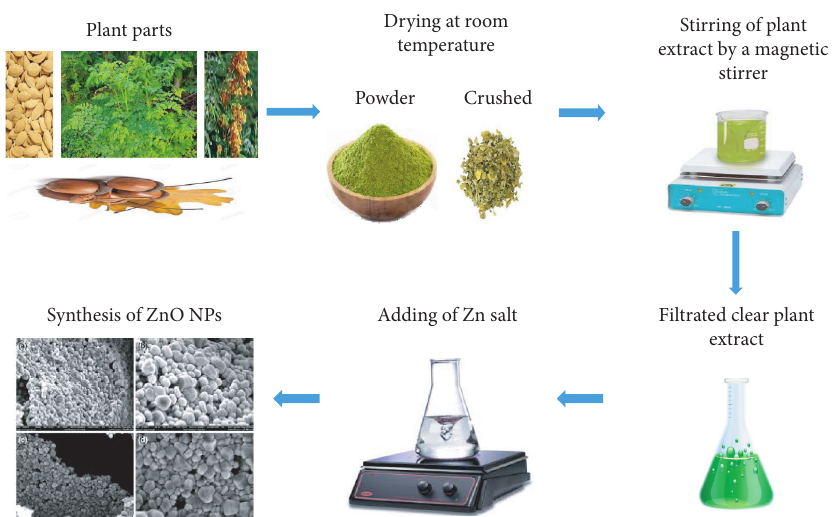
Figure 1: Proposed procedure for the biosynthesis of ZnO NPs.